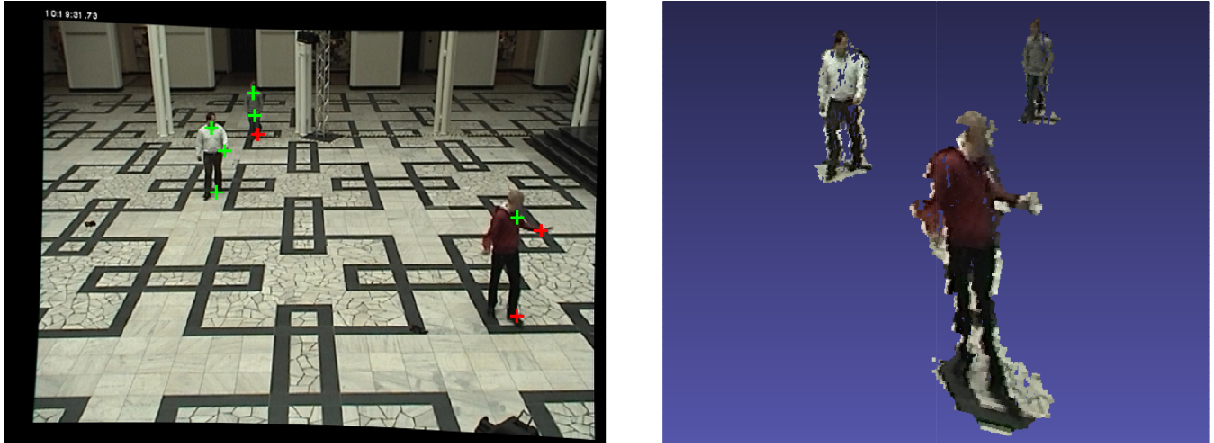
Figure 3. Sparse control points (left), inliers are depicted in green, outliers in red. The right part depicts the corresponding reconstructions.